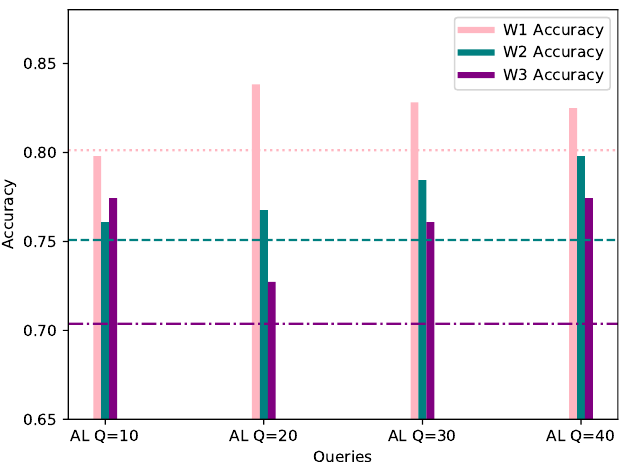
Figure 4. Accuracy of W1, W2 and W3’s models personalized with 20% AL dataset bias ( Y -axis) per Query ( X -axis), evaluated using their corresponding evaluation datasets. The FL accuracy for each worker is represented by the horizontal line of the worker’s respective color.